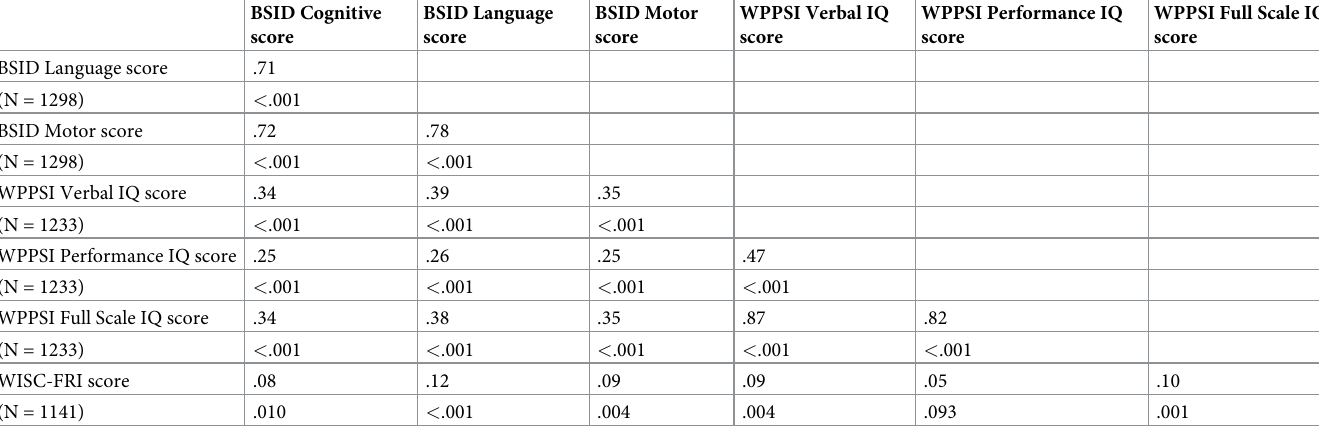
The BSID III at 24 months explained 15% of the variation of the WPPSI FSIQ, 16% of the VIQ and 8% of the PIQ (Table 4). For the WISC V FRI scores at 7–8 years, the BSID III explained 1% (Table 5). Analysis including anthropometric and sociodemographic variables with BSID III in the model, increased the explained variance with the WPPSI III to 20% and of the WISC FRI to 2% (S1 Table). Notably, models including only anthropometric and sociode- mographic variables explained 13% and 0.5% of the variance of the WPPSI III and the WISC FRI, respectively. The mean difference between WPPSI and WISC scores in the BSID reference group (BSID III scores > -1SD (85) and the other two BSID categories (BSID III scores between -1 and -2 SD (70 to 85) and < -2SD ( < 70) are shown in Tables 5 and S2. The mean differences between the reference group with the other groups across the three BSID III sub-scales scores ranged from -3.45 to -5.28 for the WPPSI FSIQ. The mean differences were lower for the WISC FRI ranging from -1.33 to -4.07 (Table 6). Similar analysis for WPPSI PIQ and VIQ has been pre- sented as a S2 Table. The stratified analysis indicated higher predictive validity of BSID III in low-risk categories (not stunted, belonging to higher SES group, born to mothers who can read and write) com- pared to high-risk categories (S3 and S4 Tables). Table 3. Correlation coefficients with p-values between the BSID III composite scores, WPPSI III Verbal, Performance and Full-Scale IQ and the WISC V FRI score of the cohort.